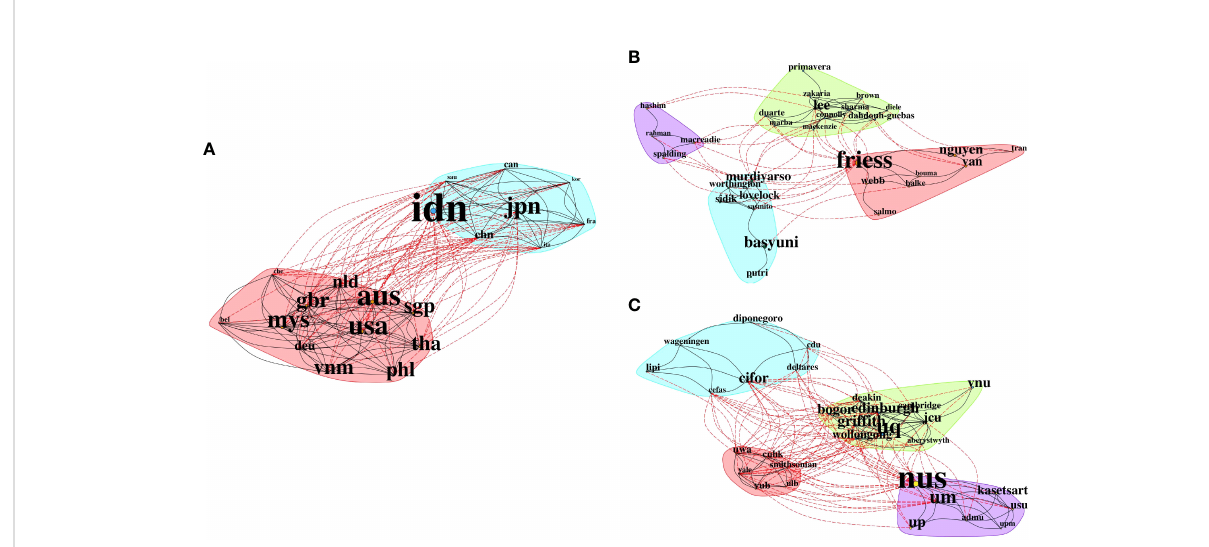
FIGURE 9 Collaboration network by (A) countries, (B) authors, and (C) institutions on mangrove restoration studies with ecological attributes in SE Asia. Country ISO and institutional codes are available in Supplementary Table